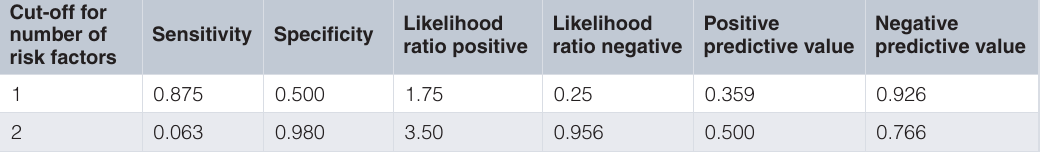
Table 6. Diagnostic value of the cut-off for the number of risk factors in predicting a difficult mask ventilation. Cut-off for number